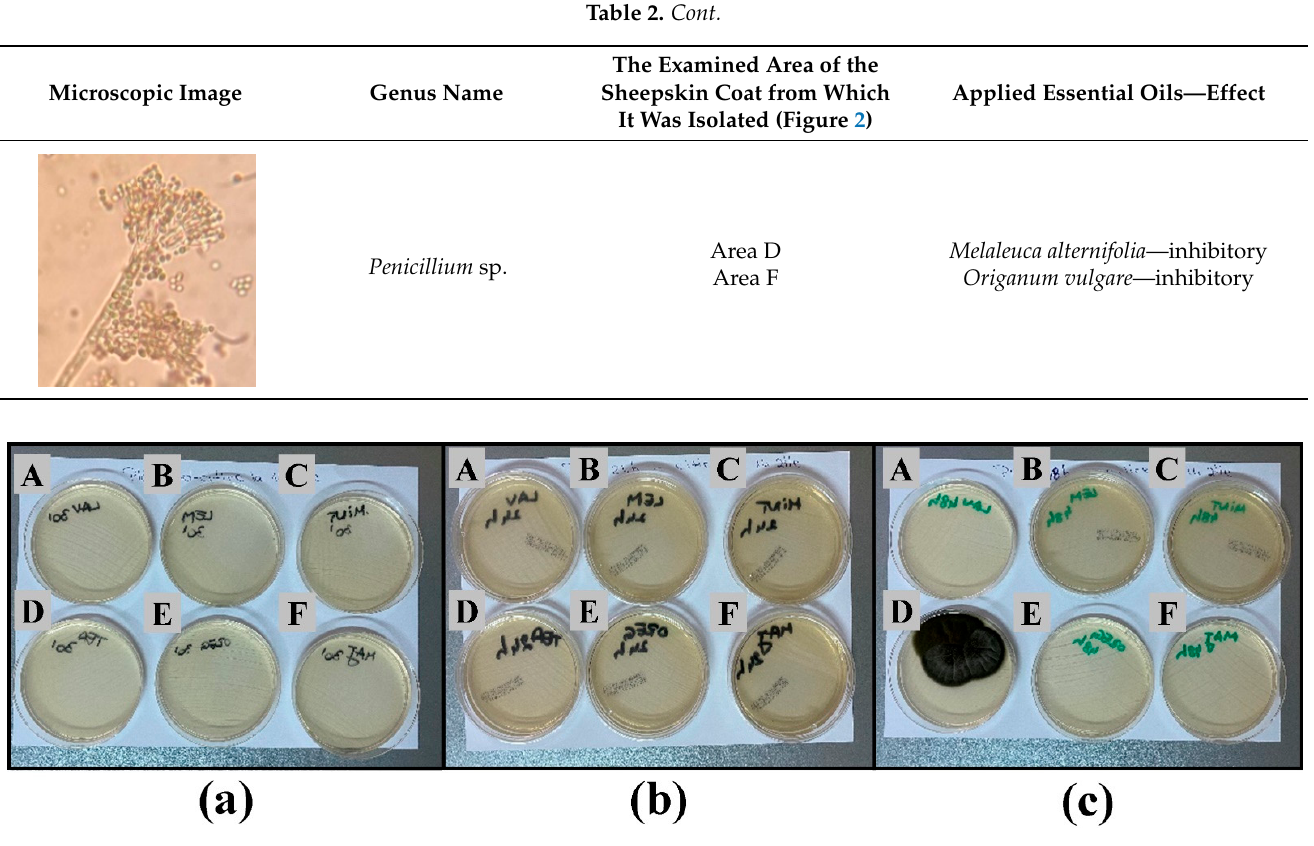
Figure 4. The plates read on day 14 of incubation: the samples at ( a ) 30 min, ( b ) 24 h and ( c ) 48 h. Figure 5a–c show the plates, as read on day 30 of the incubation. The developed colonies became macroscopically visible after between 20 days to 25 days of incubation.